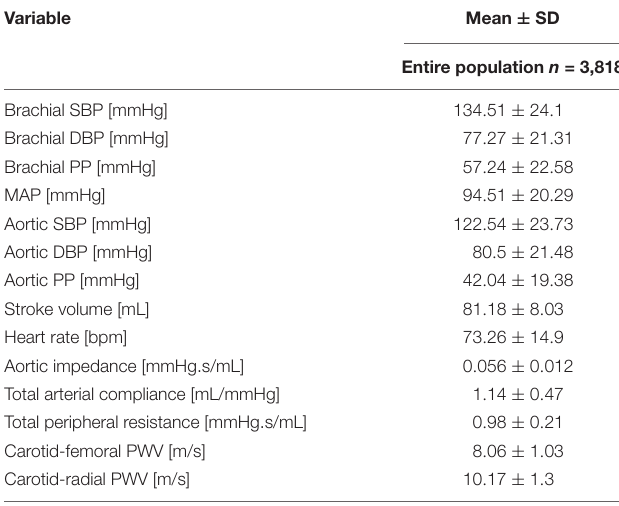
TABLE 2 | Summary of the virtual study cohort ( n = 3,818) cardiovascular characteristics.